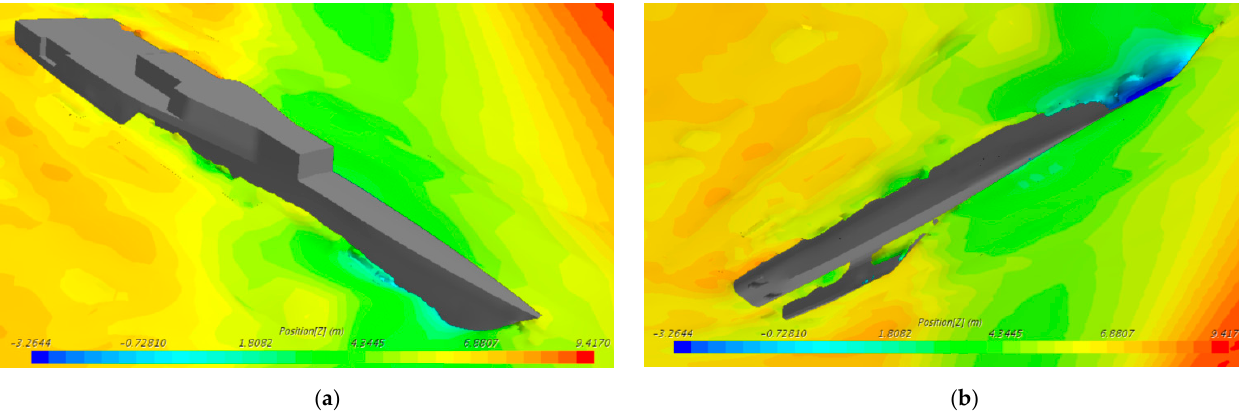
Figure 20. Full emergence of the left-side hull. ( a ) View above the free surface; ( b ) View below the free surface.